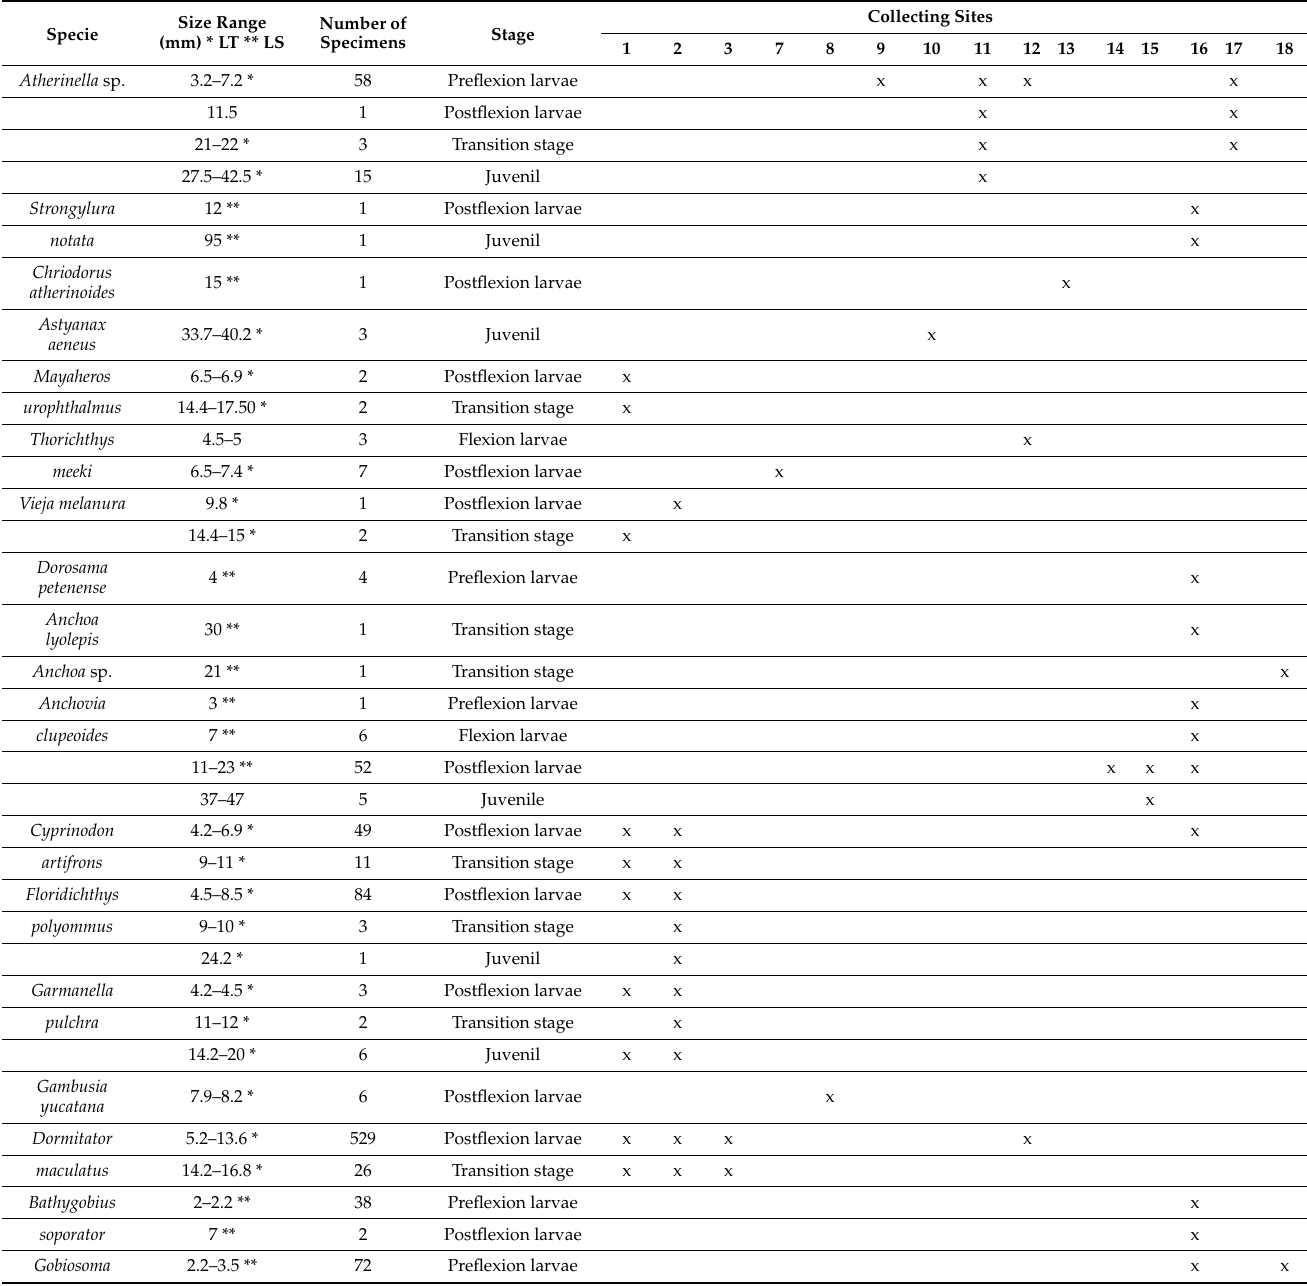
Table 3. Species, size range, number of specimens, stage of development and collection sites: (1) Muyil, (2)